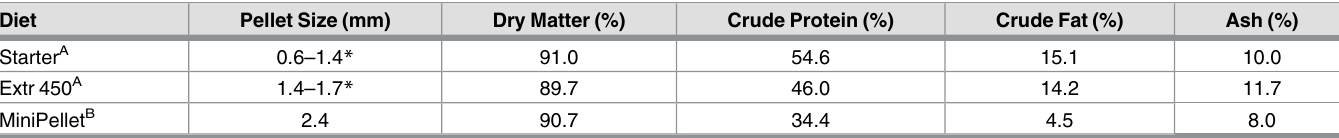
Table 1. Proximate analysis of diets fed to channel catfish throughout the study. Proximate analysiswas conductedin duplicatefor each sample, with averagesdisplayed. Starter was administeredfrom first feedingto 65 dph, Extr450 between65 and 125 dph, and MiniPelletbetween125 and 193